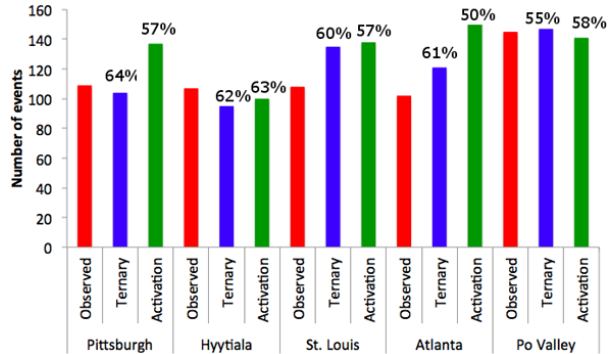
Fig. 3. New particle formation event frequency for one year across the five datasets and simulations. Observations are in red, ternary with a 10 − 5 tuning factor nucleation simulation is in blue, and acti- vation nucleation simulation is in green. Numbers above the ternary and activation columns represent the percentage of matching events or non-events for the two model cases compared to